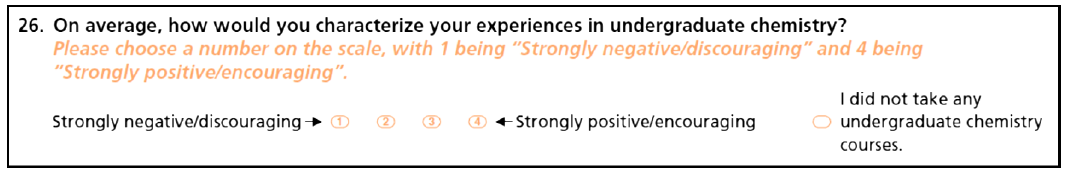
FIG. 5 (color online). Question No. 26 from the Project Crossover Survey on Experiences in Undergraduate Chemistry Course.